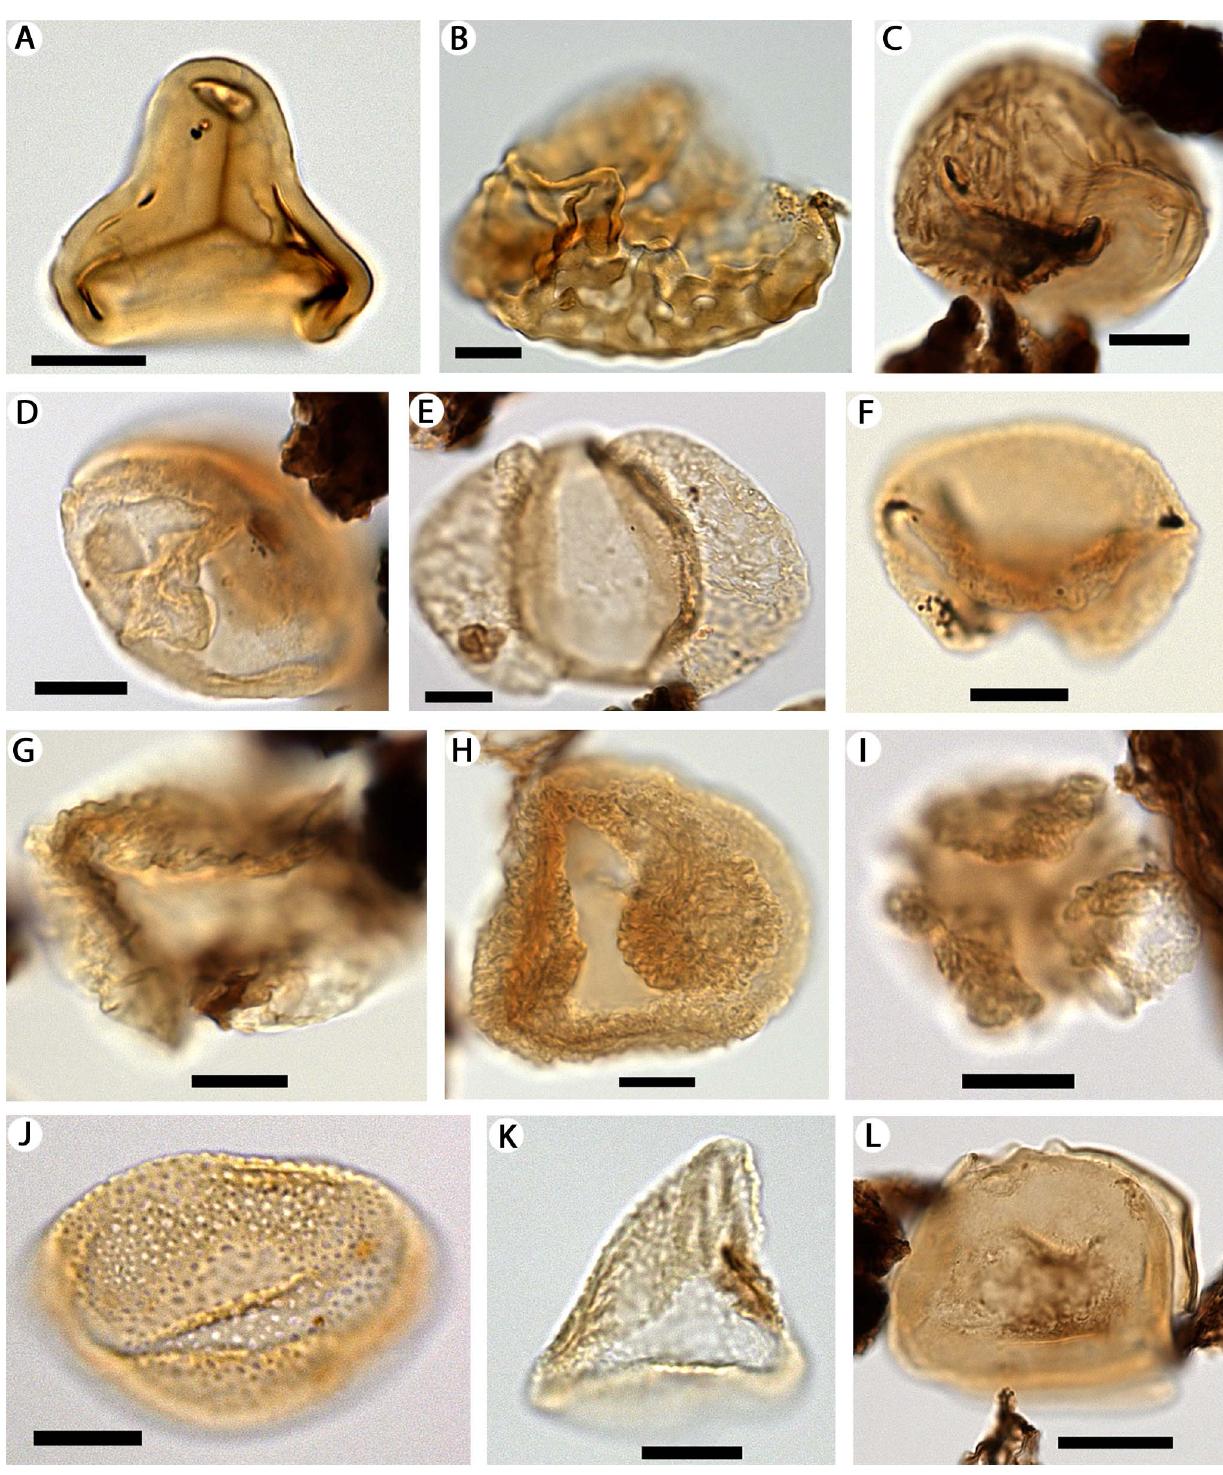
Figure 3. Microscope images of cryptogam spores (A–C), other gymnosperm pollen (D–I) and monocot pollen (J–L) from the Rı´o Zeballos locality. Suggested extant affinities, if known, are shown in parentheses. A, Cyathidites sp. (Cyatheaceae). B, Ischyosporites areapunctata (Stuchlik) Barreda (Dicksoniaceae). C, Reboulisporites fuegiensis Zamaloa & E.J. Romero (Aytoniaceae). D, Phyllocladidites mawsonii Cookson ex Couper ( Lagarostrobos ). E, Podocarpidites marwickii Couper ( Podocarpus / Prumnopitys ). F, Podosporites microsaccatus (Couper) M.E. Dettmann ( Microcachrys ). G, Dacrycarpites australiensis Cookson & K.M. Pike ( Dacrycarpus ). H, Dacrydiumites florinii Cookson & K.M. Pike var. ( Dacrydium ). I, Microcachryidites antarcticus Cookson ( Microcachrys ). J, Liliacidites cf. L. r egularis Archangelsky (Liliaceae). K, Luminidites sp. (Agavaceae). L, Proxapertites sp. (Araceae/ Arecaceae). Scale bars: A–K, 10 m m; L, 20 m m.